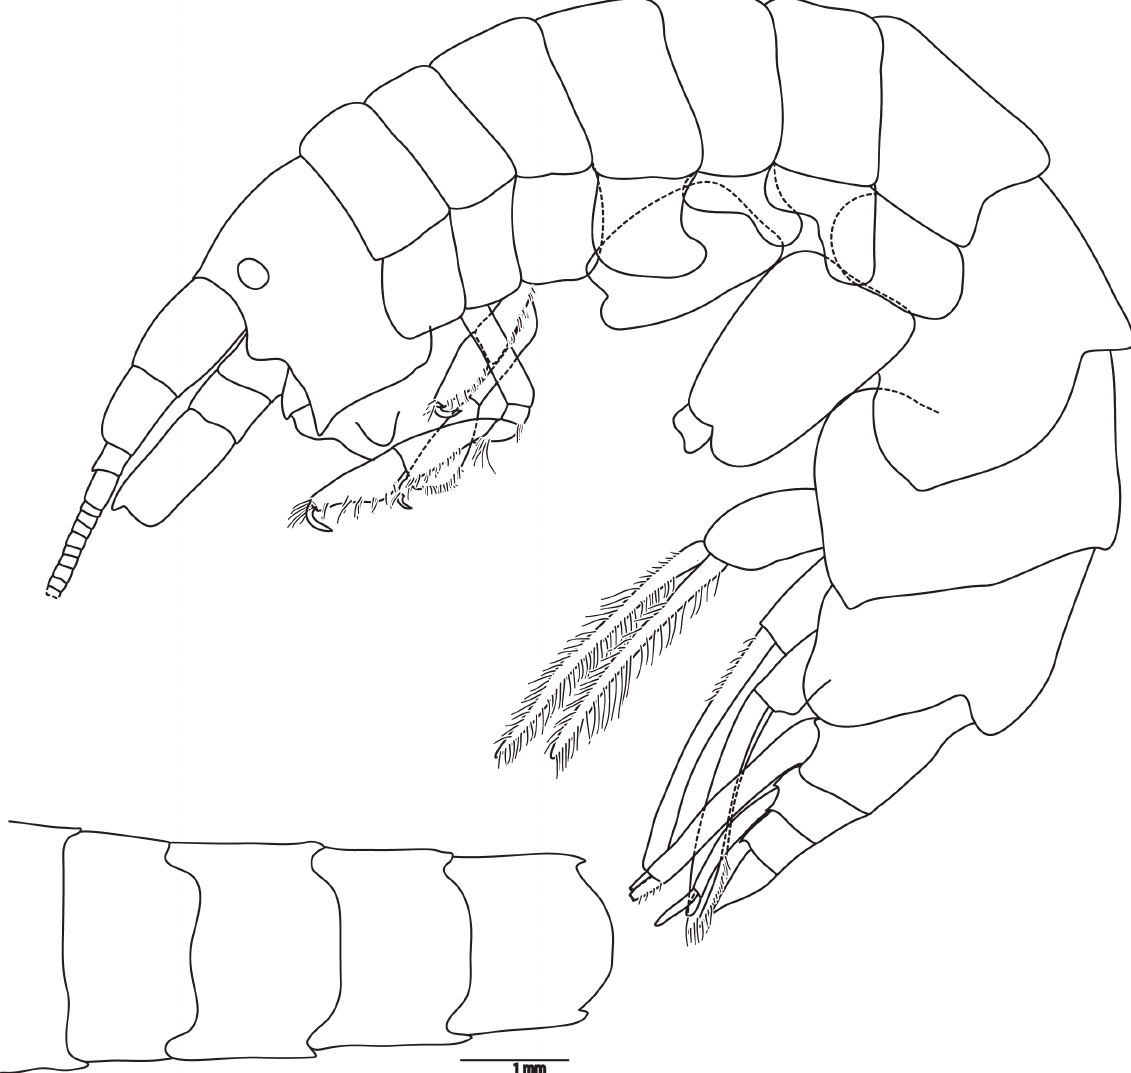
Fig. 2. Halirages helgae sp. nov. A . Holotype, ♀ , 10 mm long. B . Dorsal side, showing bilobed posterior margin of pereonite 7; paratype 1, ♀ , 10 mm